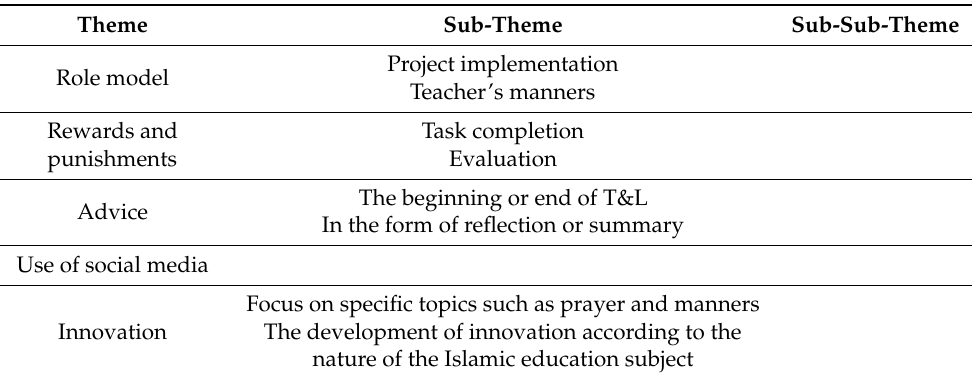
Table 3. The theme of creative methods in applying moral values during 21CE